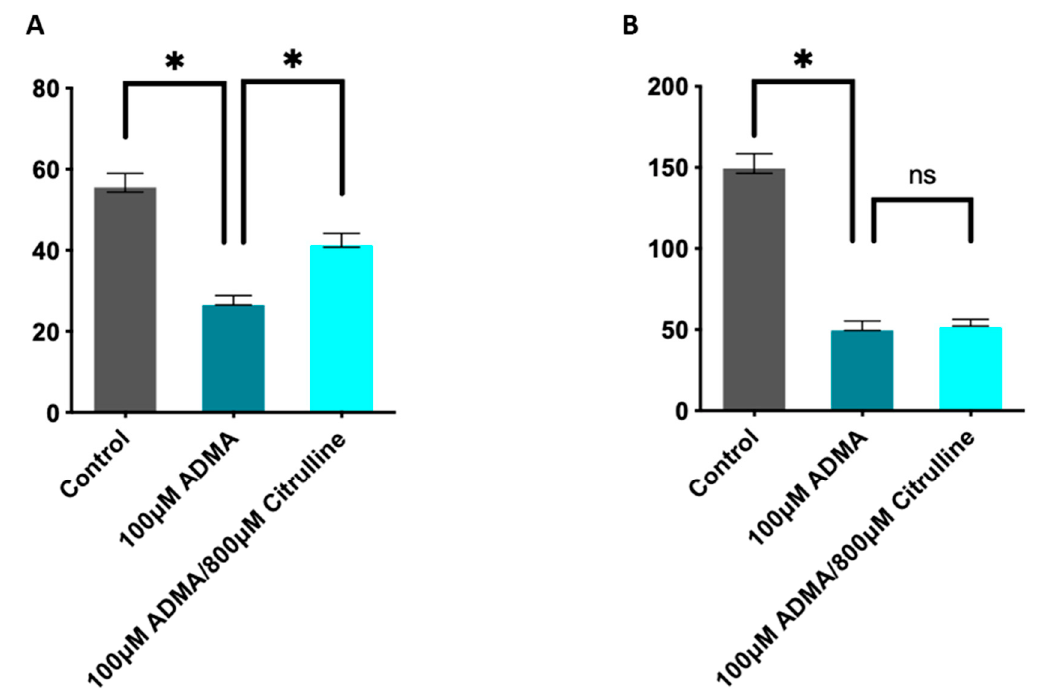
Figure 5. Addition of L-citrulline prevented asymmetric dimethylarginine (ADMA)-mediated reduction of NO metabolites in HBECs. ( A ). NO metabolites measurement in human bronchial epithelial cells (HBECs) exposed to low (25 µ M) L-arginine cell media concentration; ( B ). NO metabolites measurement in HBECs exposed to high (100 µ M) L-arginine cell media concentration. ( n = 3–5 repeats per group). All experiments were repeated 3 times. Mean ± s.e.m. ns not significant. * p < 0.05.